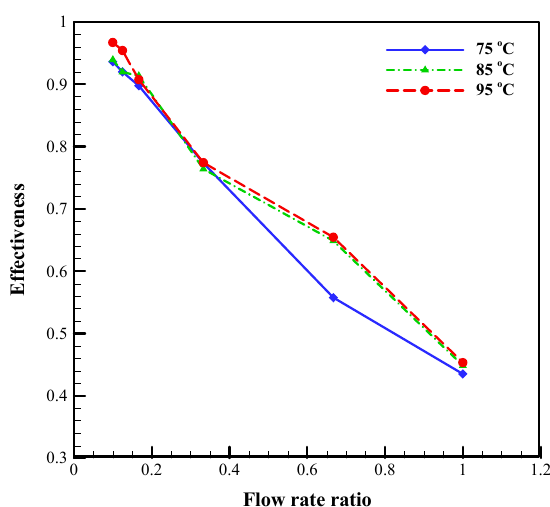
Figure 4. The effectiveness of the PCHE on different hot inlet temperatures.